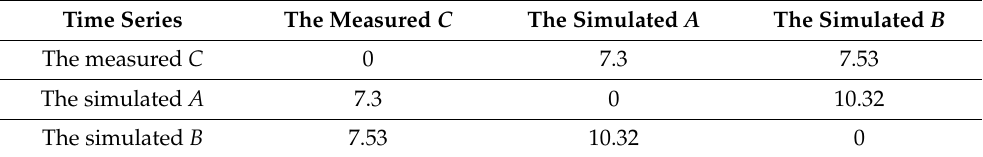
Table 5. Dynamic time warping distance calculation results (calculation period [0, 600]).